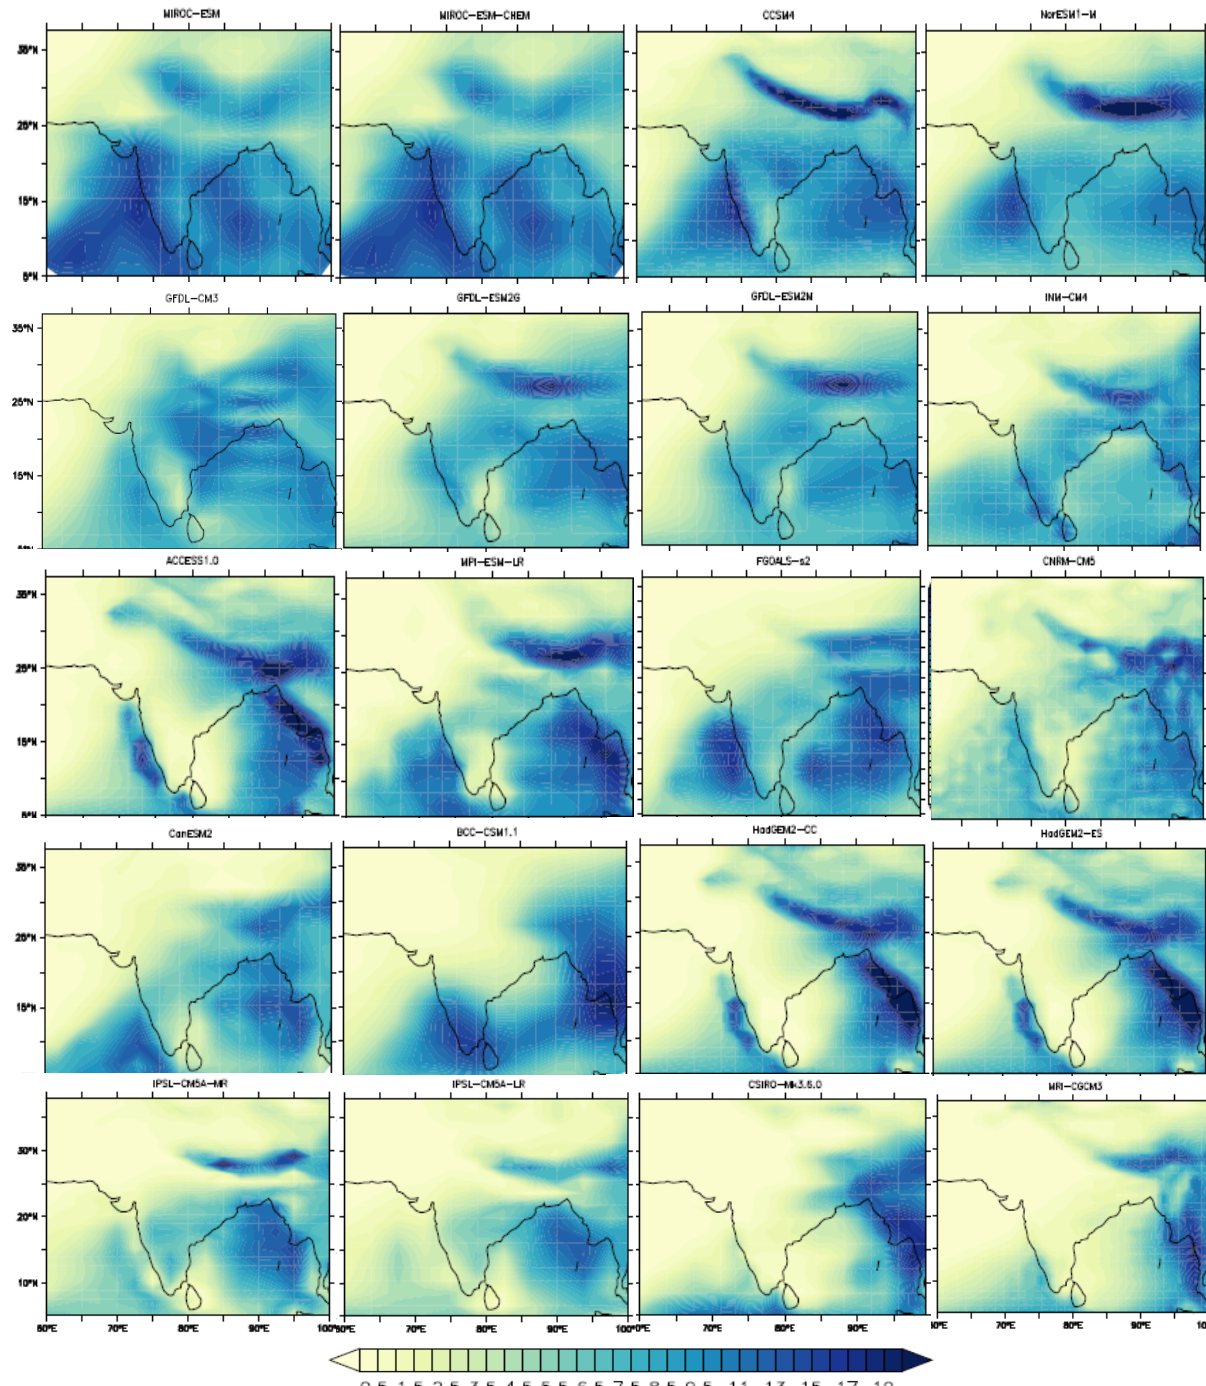
Fig. 3. June–September (JJAS) rainfall climatology (mmday − 1 ) during the period 1871–2004 for all 20 models. Models with lowest seasonal mean rainfall do not capture the spatial pattern realistically. The models are shown in the same order as in Fig. 1.